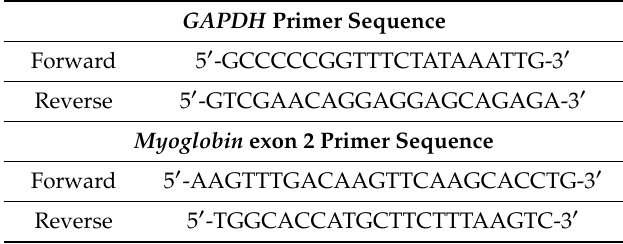
Table 1. PCR primer sequences for target gene regions, performed by DIP-qPCR